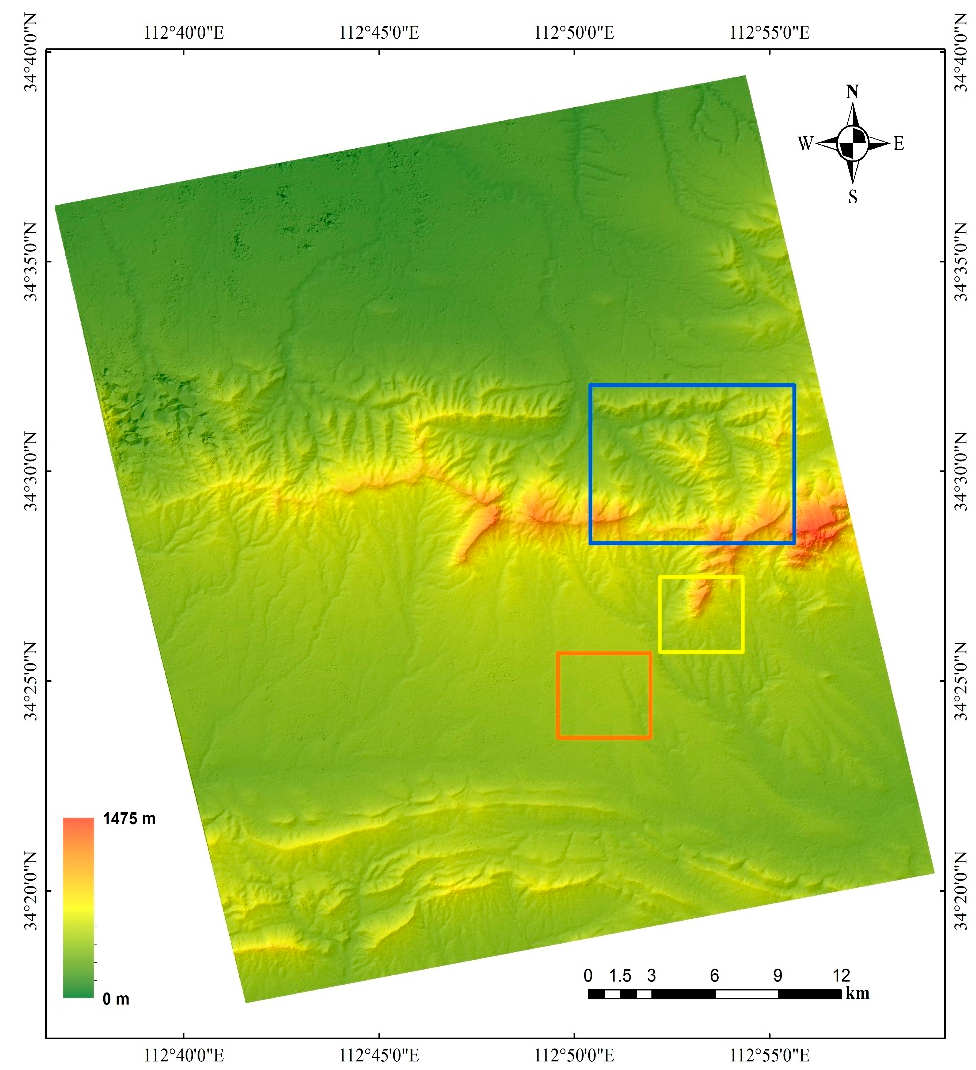
Figure 4. DSM with hillshading produced by SGM_canny algorithm from the Stripmap pair.